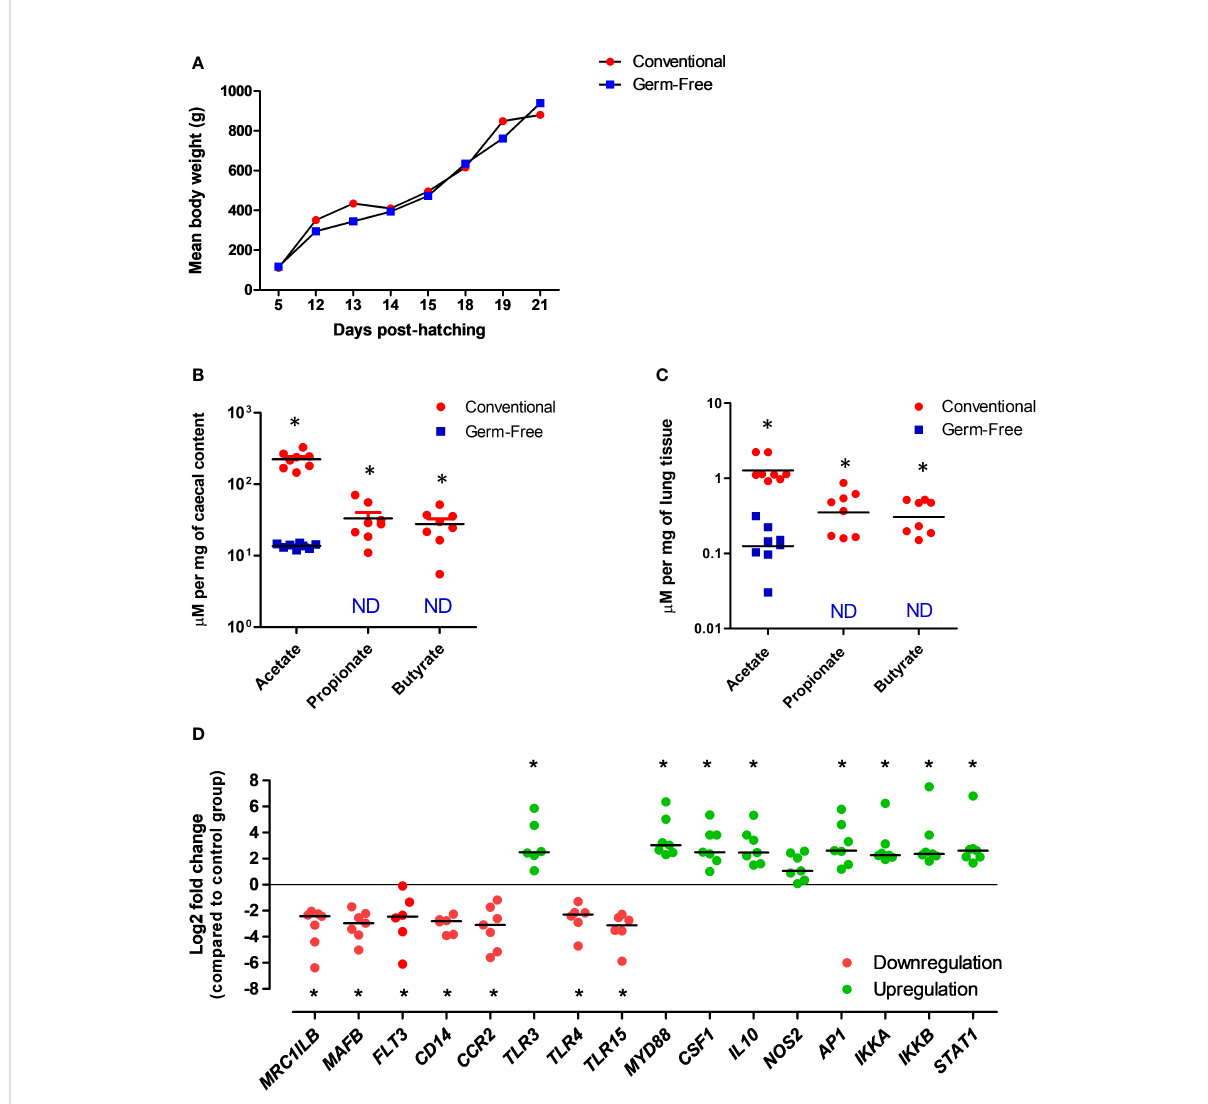
FIGURE 3 Evidences for the existence of a functional gut-lung axis in the chicken. (A) Germ-free and conventional inbred White leghorn chickens raised in isolators possess no differences in weight gain during the fi rst 3 weeks of life, suggesting no major physiological anomalies. (B) Concentrations of acetate, propionate and butyrate in the caecal contents of conventional and germ-free chickens at 21 days of age as quanti fi ed by 1 H-NMR. Although acetate can still be detected, possibly from the diet, propionate and butyrate are absent from germ-free caecal contents. (C) Concentrations of acetate, propionate and butyrate in the lungs of conventional and germ-free chickens at 21 days of age as quanti fi ed by 1 H-NMR. Although residual concentrations of acetate are present, propionate and butyrate are undetectable in the lungs of germ-free chickens. Concentrations are shown in µM per mg of caecal content or tissue. ND, not detected (or below the threshold). (D) qRT-PCR analysis revealed changes in the expression of selected immune-related genes in the lungs of germ-free chickens at 21 days of age. Relative normalized expression was calculated using the 2 − DD Ct method and data are represented as Log2 fold change as compared to the conventional chickens group. Values are the median. *P<0.05. All experimental protocols and primer pairs used for the qRT-PCR analysis are shown in the Supplementary